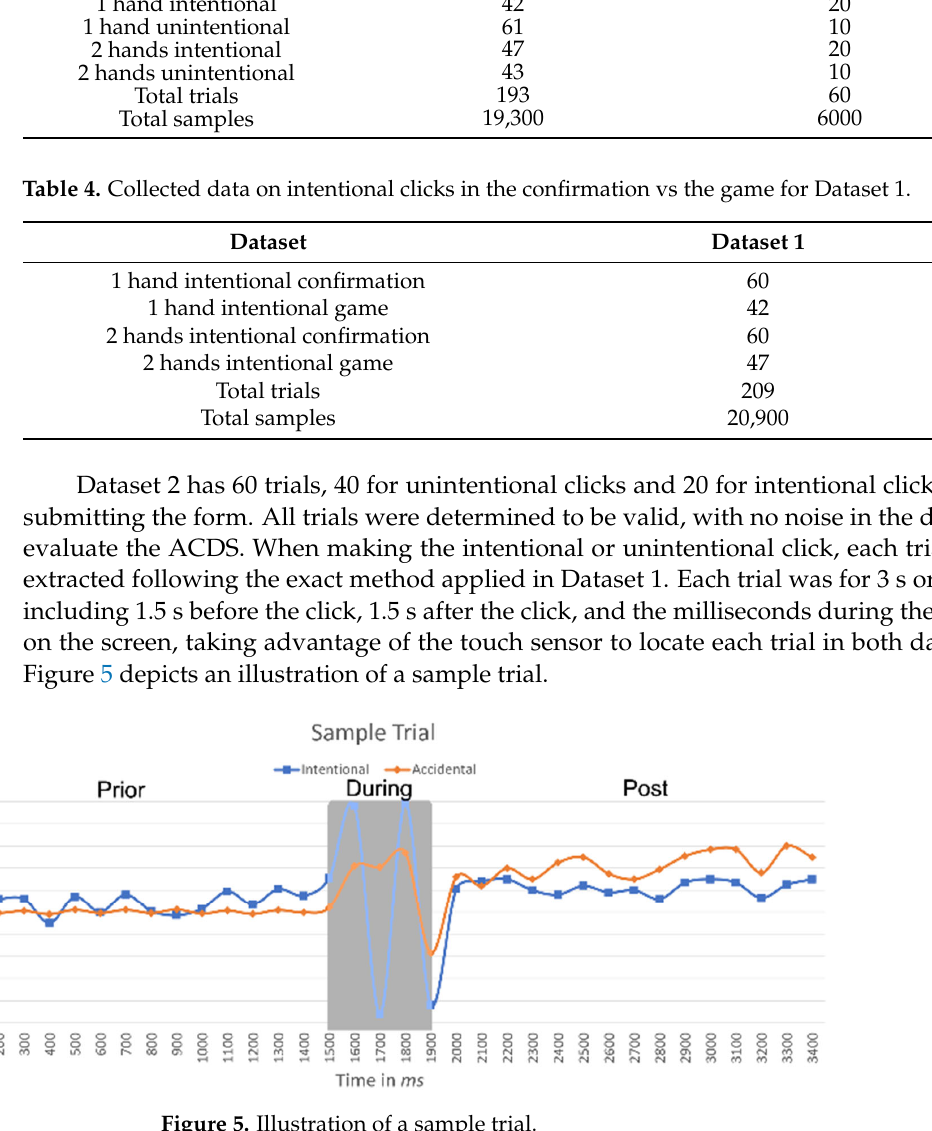
Figure 5. Illustration of a sample trial.